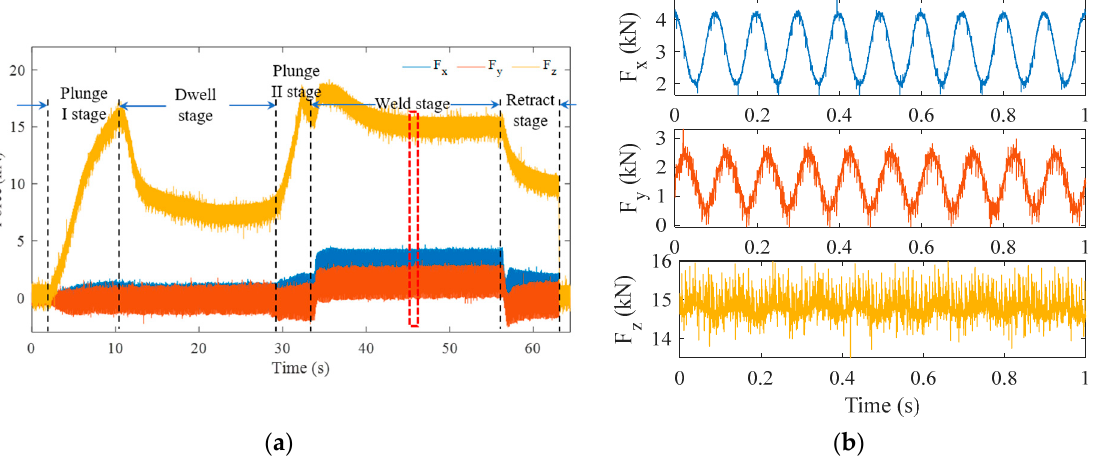
Figure 2. Typical three-dimensional force acquired at the welding speed of 160 mm/min and rota- tional speed of 600 rpm: ( a ) the whole process; ( b ) enlarged view of red box in ( a